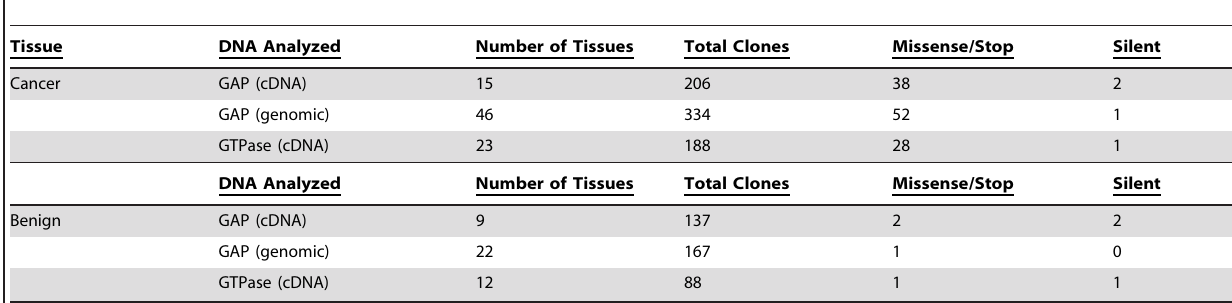
Table 3. Summary of mutation analysis of GAP and GTPase.